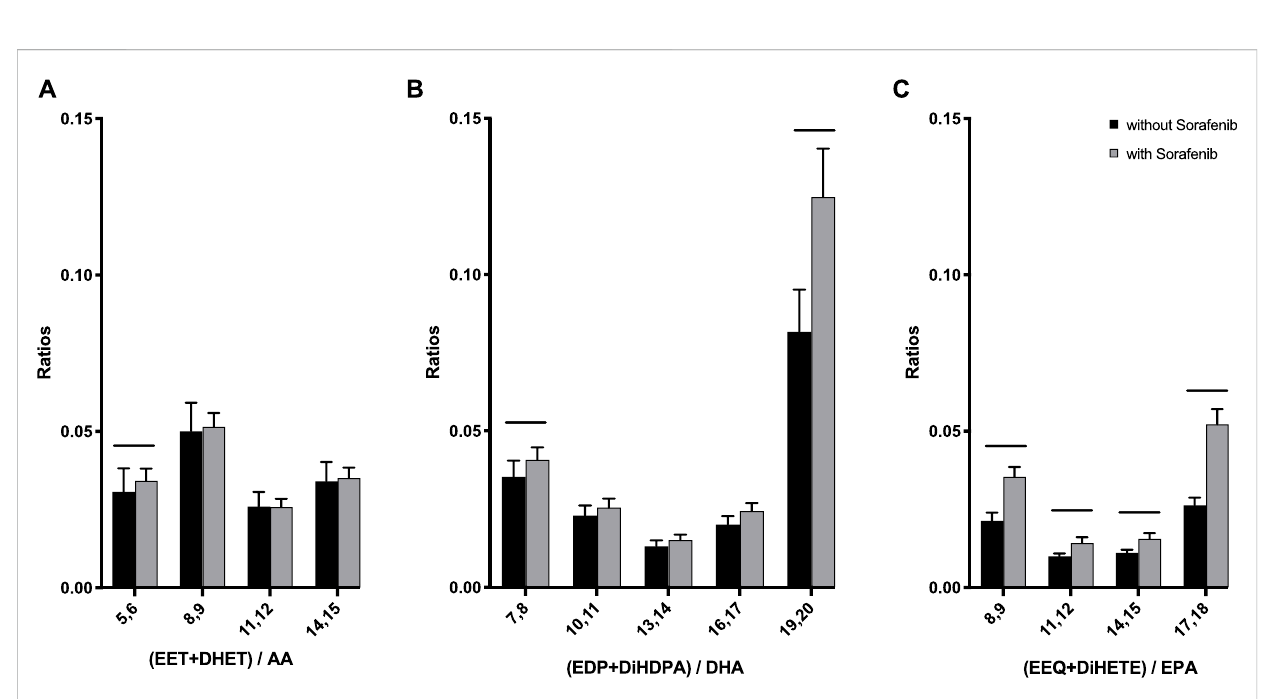
FIGURE 5 N-3andn-6PUFA-derivedepoxidesplusdihydroxycompoundsasamarkerforthepresenceofCYPmetabolitesinplasmafrom n =43patientswith HCC without and undergoing sorafenib treatment. (A) Ratio of AA-derived products divided by AA plasma content, (B) ratio of DHA-derived products divided by DHA plasma content, (C) ratio of EPA-derived products divided by EPA plasma content (* p < 0.05, ** p < 0.01; *** p < 0.001; **** p <